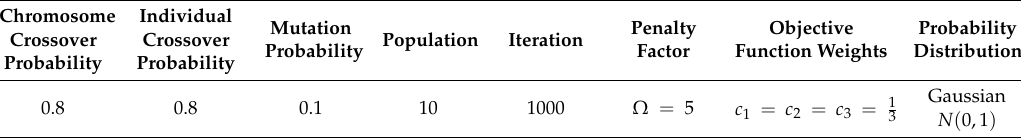
Table 8. Parameter settings for the algorithm.